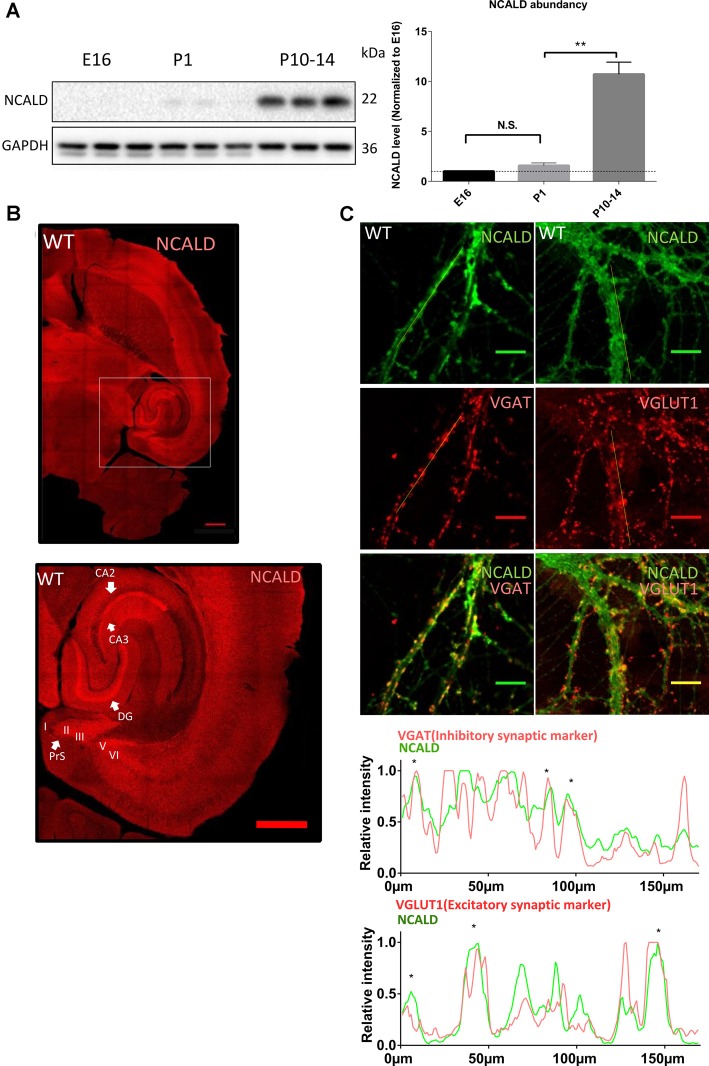
NCALD is enriched postnatally and in presynaptic terminals. (A) Western blot analysis of NCALD levels in brain lysates derived from the embryonic stage 16 (E16), postnatal day 1 (P1) and postnatal day 14 (P14) WT mice. Dots plots quantification reveals a 10-fold increase in the NCALD level in P10–14 brains; **P < 0.01; N.S. = not significant. (B) Representative confocal images of a WT brain immunostained for the NCALD, showing high protein expression in the forebrain and the midbrain and its abundance in the hippocampal and parahippocampal regions (magnified area); scale bar 500 μm. (C) Representative confocal images of cultured WT hippocampal neurons stained with NCALD antibody (green) and co-stained with synaptic markers VGLUT1 and VGAT (red), showing NCALD enrichment in the presynaptic terminals; scale bar 10 μm. Dotted white lines indicate areas taken for line plot analysis, where fluorescent signal for each channel is plotted relative to the distance. Asterisks in line plots represent the colocalization of NCALD with either VGLUT or VGAT. Uncropped Western blots are included in Supplementary Data Sheet 8.